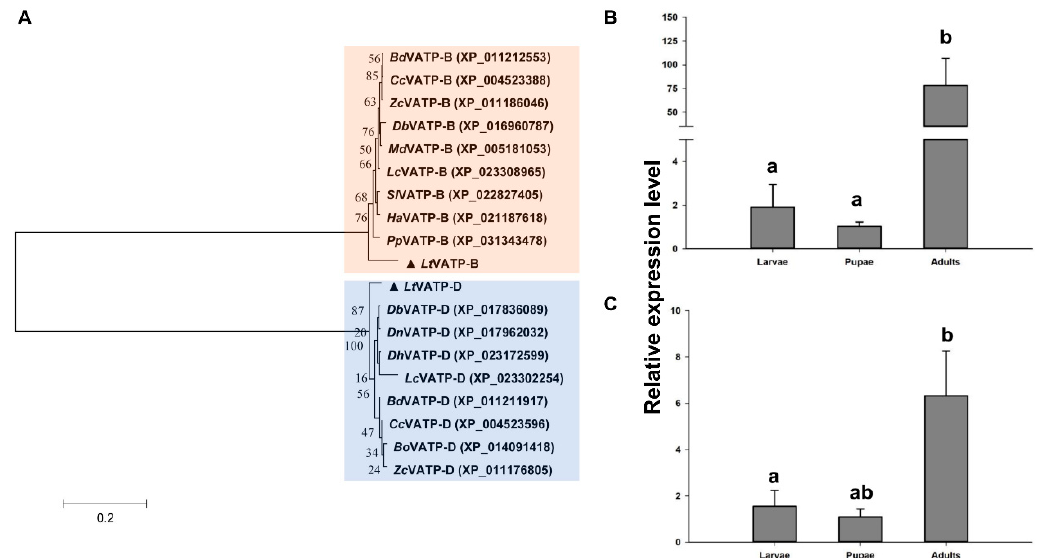
Figure 2. Neighbor-joining phylogenetic tree and relative expression analysis of V-ATPase B and V-ATPase D . ( A ) Phylogenetic tree. L. trifolii V-ATPase B and D are labeled with triangles. Numbers on the branches represent bootstrap values obtained from 1000 replicates (only bootstrap values > 50 are shown). Species names and accession numbers are listed in Table S1. ( B ) Relative expression of V-ATPase B and ( C ) V-ATPase D in L. trifolii larvae, pupae, and adults. Different lowercase letters in panels ( B , C ) indicate significant differences between developmental stages. Tukey’s multiple range test was used for pairwise comparison of means ( p < 0.05).